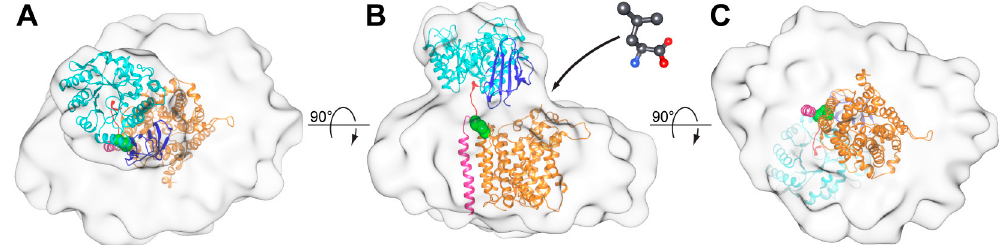
Figure 5. Structural model of the 4F2hc-LAT2 heterodimeric complex based on the cryo-EM 3D-map. The model is shown from the extracellular side ( A ), the membrane plane ( B ), and the cytoplasmic side ( C ). The structure of 4F2hc-LAT2 is displayed as ribbon representation, and the structural elements of 4F2hc-ED (PDB ID code 2DH2) are colored as in Figure 4 (N-terminal region, red; TIM-barrel subdomain, cyan; C-terminal eight antiparallel β -strand subdomain, blue). Whereas the modeled TMD of 4F2hc is shown in magenta, the LAT2 homology model (LAT2 HM ) is presented in orange. Individual atoms of the disulfide bridge between 4F2hc and LAT2 are shown as green spheres. In panel ( B ) the putative substrate entry side is represented by an L-Leu molecule (grey sticks) and an arrow.